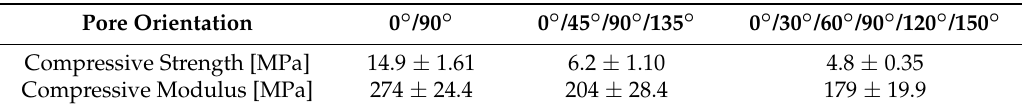
Table 3. Compressive strengths and modulus of the porous CaP scaffolds with different pore